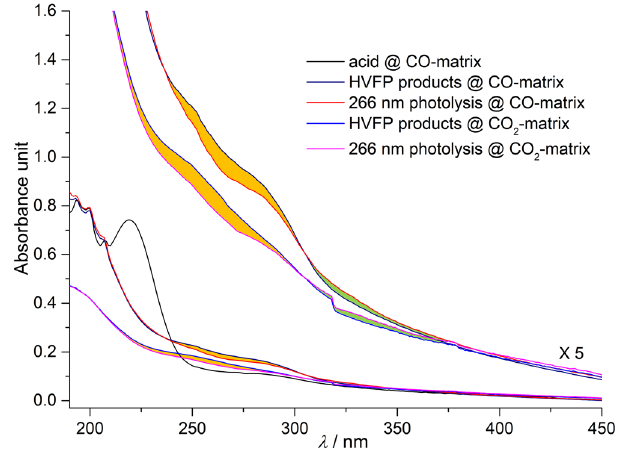
Fig. 3 | Ultraviolet-visible (UV ‒ vis) spectra of the acid precursor CHF 2 S(O)OH and its high-vacuum fl ash pyrolysis (HVFP) products isolated in solid CO